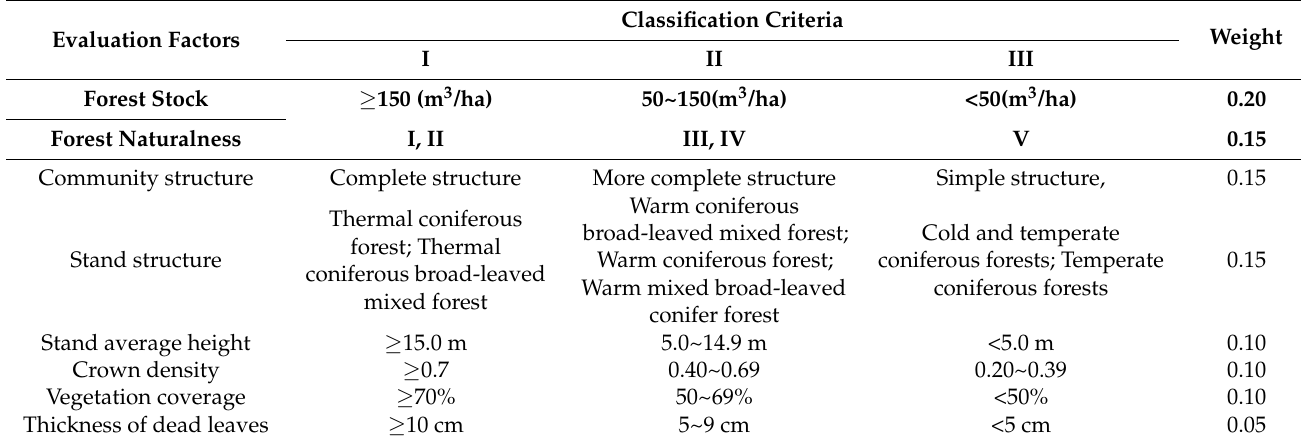
Table A1. Ecological index division standard table.